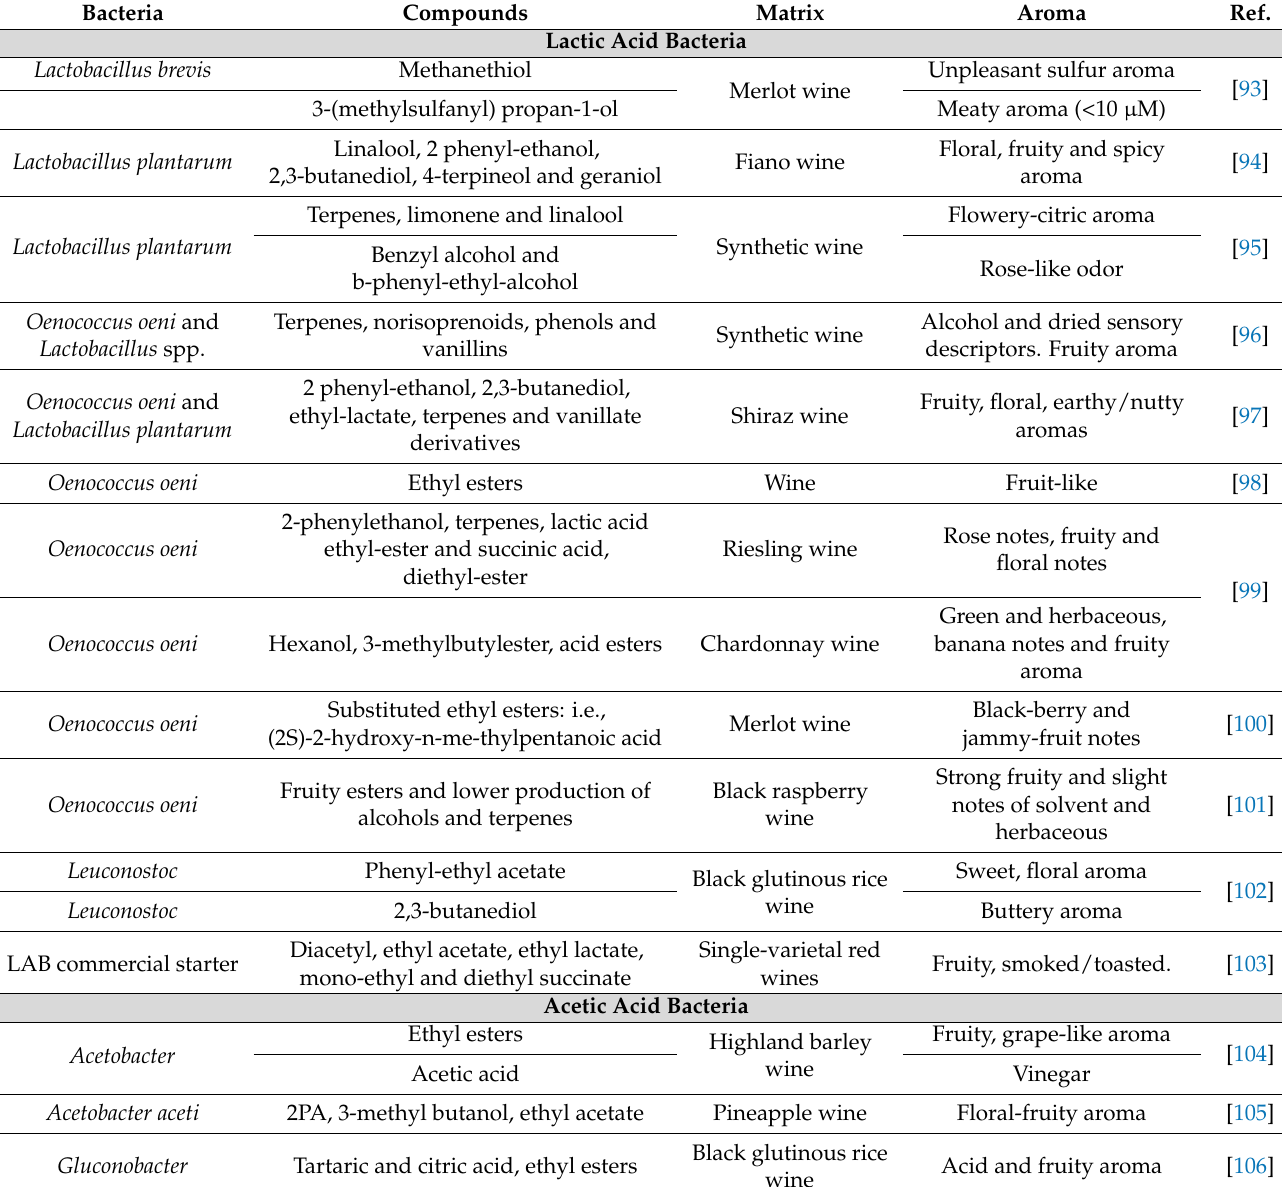
Table 3. Different aroma compounds produced by lactic and acetic acid bacteria